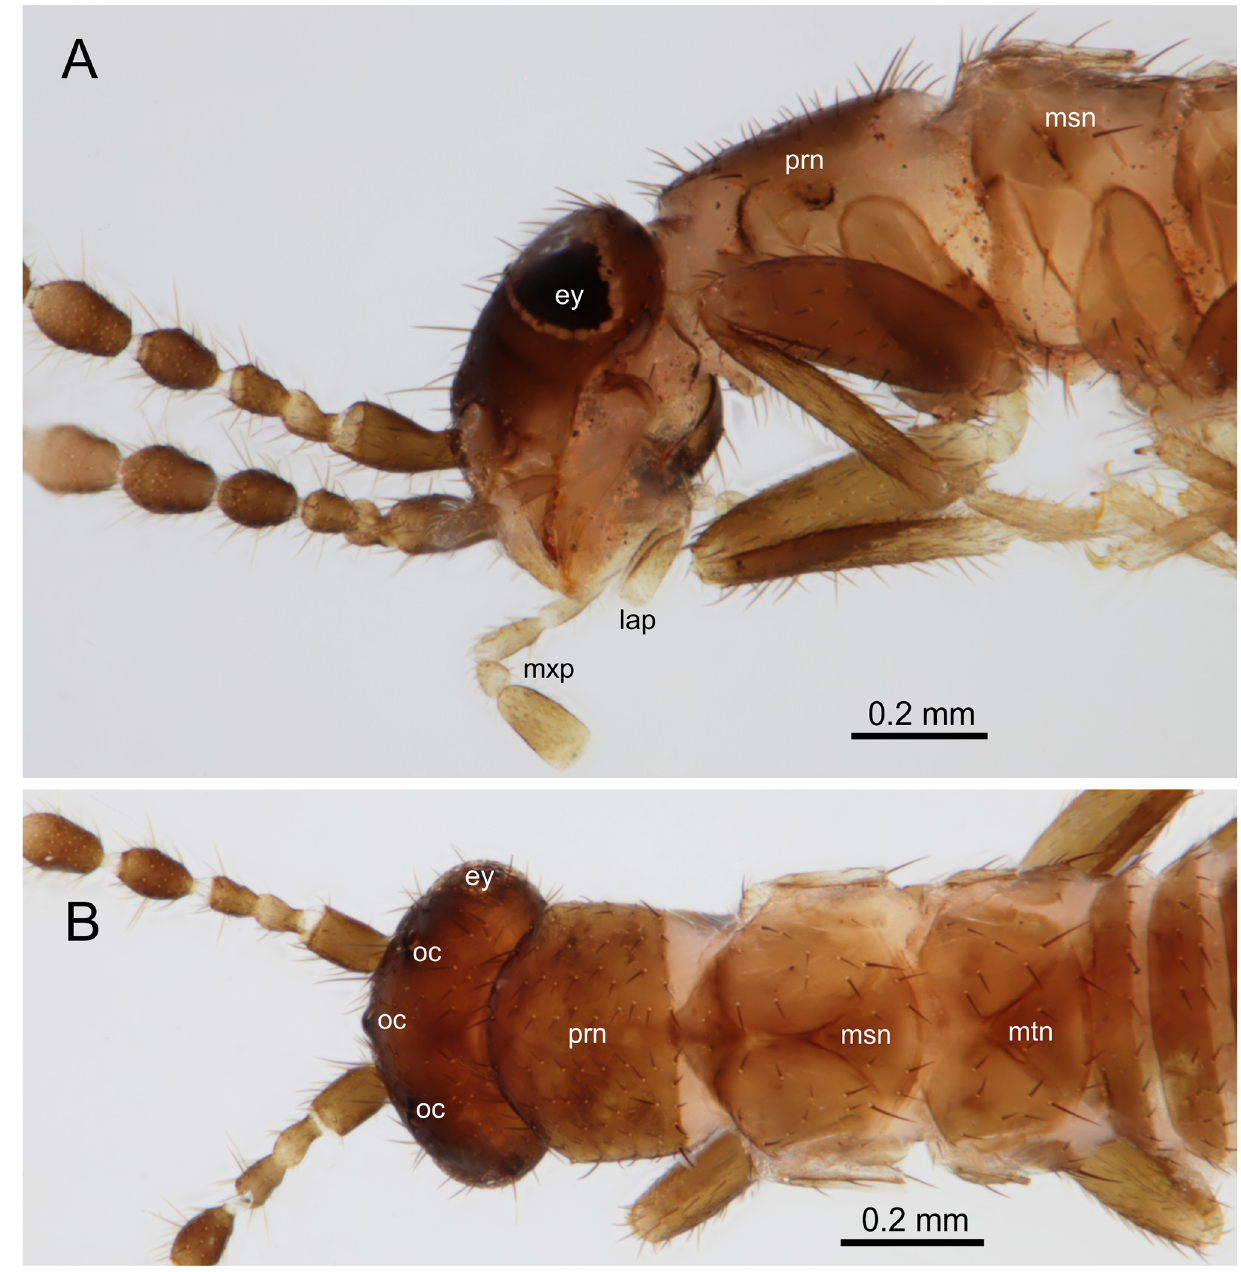
Fig 3. Latinozoros cacaoensis sp. nov., dealate female paratype. A: Ventro-lateral view of head and thorax; B: Dorsal view of head and thorax. Abbreviations: ey–compound eye; oc–ocelli; lap–labial palpus; prn–pronotum; msn–metanotum; mtn–metanotum; mxp–maxillary palpus. Scale bars = 0.2